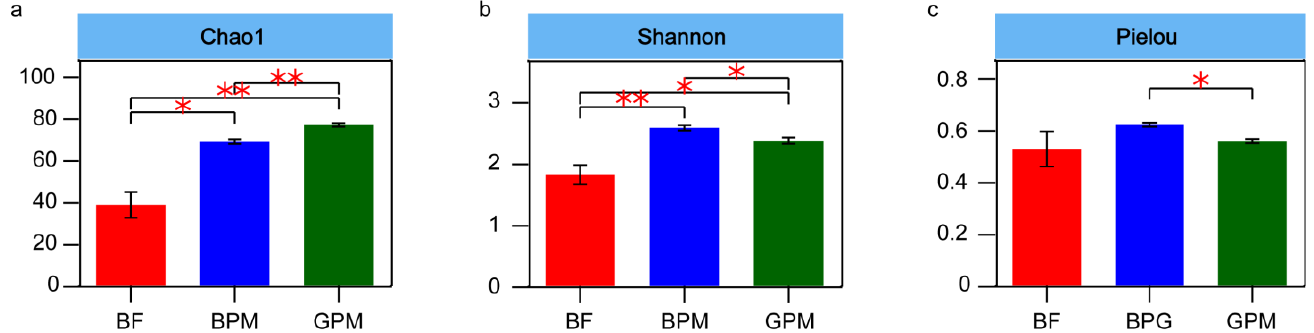
Figure 2. Analysis of the α -diversity of microbial communities. ( a ) Chao 1 index; ( b ) Shannon index; and ( c ) Pielou index. BF refers to the elephant milk-only diet group, BPM refers to the elephant milk – plant mixed-feed diet group, and GPM refers to the goat milk – plant mixed-feed diet group. * refers to p < 0.05, ** refers to p < 0.01.